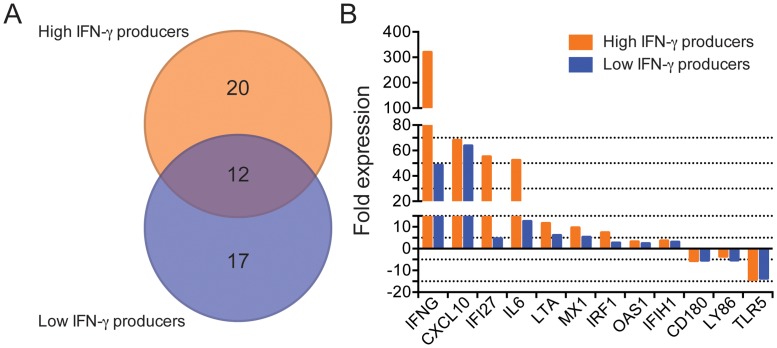
Genes modulated in High- or Low- IFN-γ producers following stimulation with L. braziliensis.PBMCs from High IFN-γ Producers (HPs) (n = 3) and from Low IFN-γ Producers (LPs) (n = 3) were stimulated with L. braziliensis for 72h. Gene expression was determined using total RNA and arrays covering Th1-Th2-Th3 responses, IFN-γ and receptors, chemokines and receptors and TLRs. (A) Venn diagram depicting the total number of genes differentially modulated in HPs only, LPs only or modulated in both categories, as evidenced by arrays analysis (see materials and methods). (B) Fold expression of the 12 genes differentially modulated in both HPs and LPs, as evidenced by array analysis (see materials and methods).